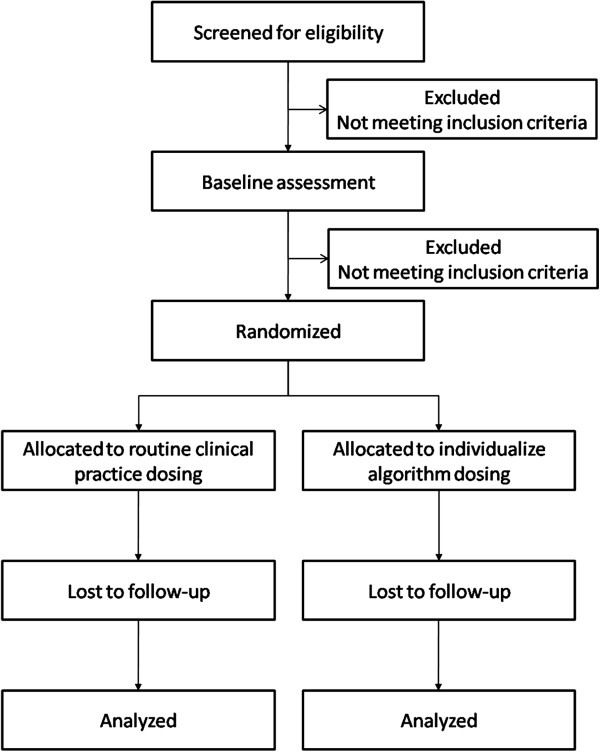
Flowchart of study procedures.